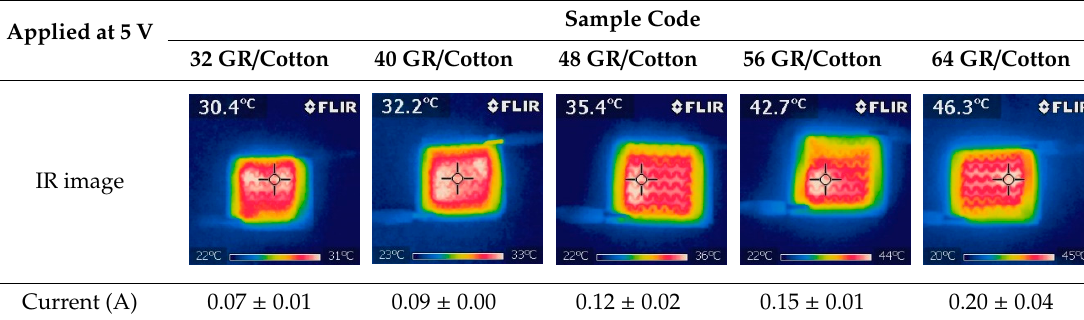
Table 4. IR thermal images and current of GR / cotton coated with various high-content of graphene nanoplatelets at 5 V.